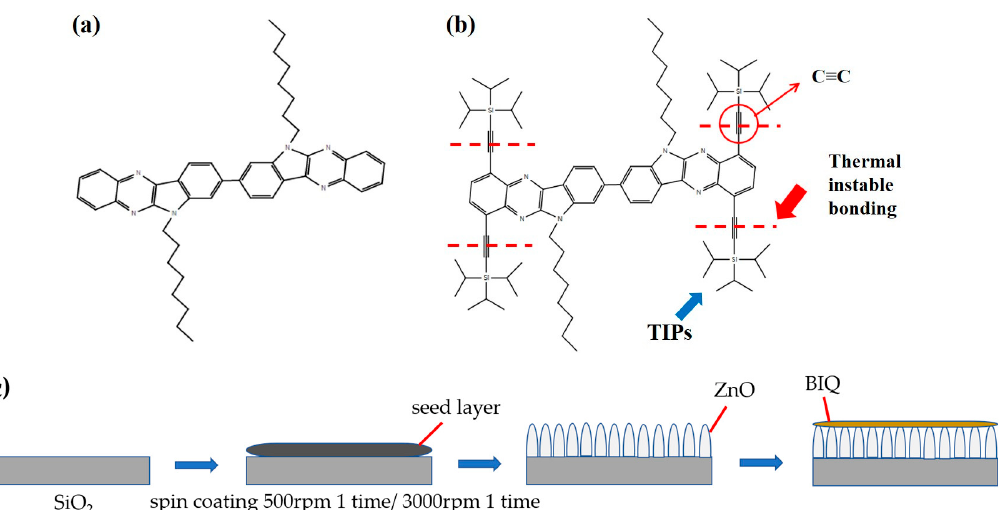
Figure 1. Chemical structure of ( a ) BIQ and ( b ) BIQ-TIPs. The TIPs moiety is marked by the red dashed lines. ( c ) The flow of the fabrication process.